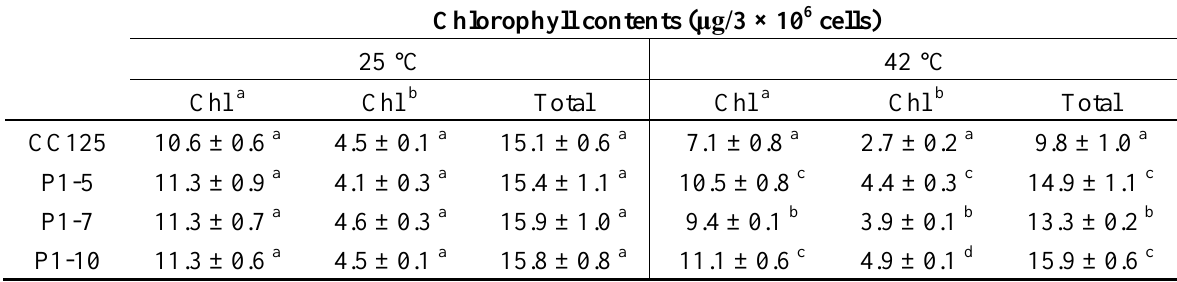
Table 1. Chlorophyll contents of transgenic Chlamydomonas overexpressing PETF